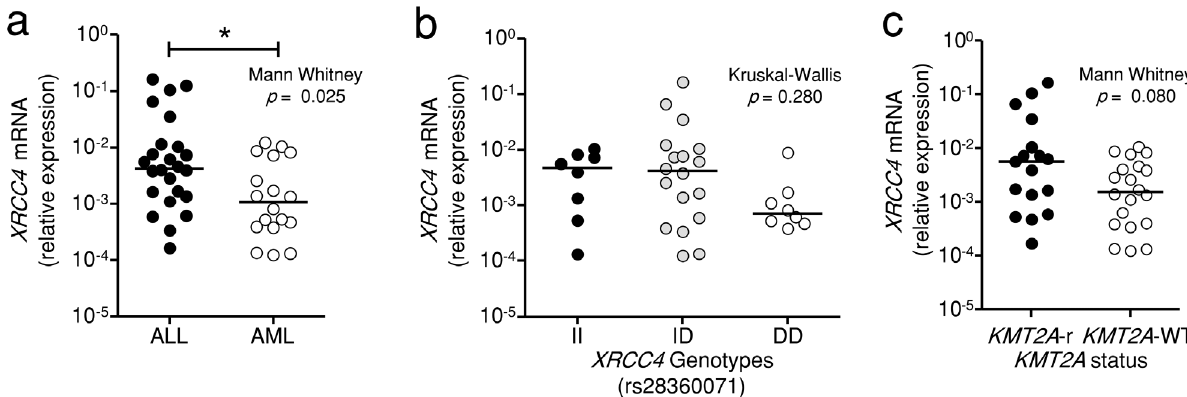
Figure 1 – Differential levels of XRCC4 mRNA in EAL bone marrow samples. (a) Comparison of the expression levels of XRCC4 in acute lymphoblastic leukemia (ALL) and acute myeloid leukemia (AML). (b) Differential levels of XRCC4 according to the genotypes for the XRCC4 rs28360071 polymorphism. (c) Comparison of XRCC4 expression levels in patients harboring KMT2A rearranged ( KMT2A -r) and KMT2A wild type ( KMT2A -WT). Experiments were performed in triplicates. Horizontal bars indicate median